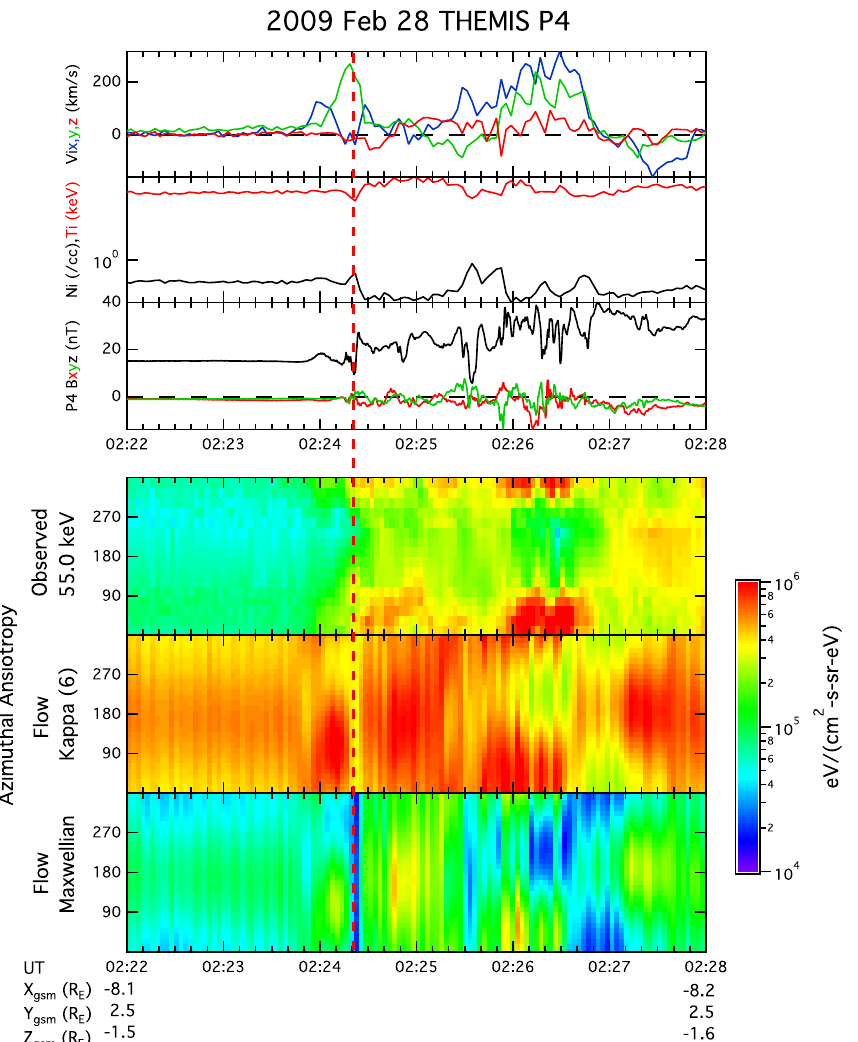
Fig. 2. Observations of current disruption/dipolarization event on 28 February 2009 from THEMIS P4. From the top to bottom are the plasma flow components in GSM coordinates (different colors are used for different components, as indicated by the label), the number density and temperature of ions, the magnetic field components in GSM coordinates (different colors are used for different components, as indicated by the label), the observed azimuthal anisotropy of 50–60keV ions, the anisotropy expected from plasma flow with a kappa distribution of κ = 6, and the anisotropy expected from plasma flow with a Maxwellian